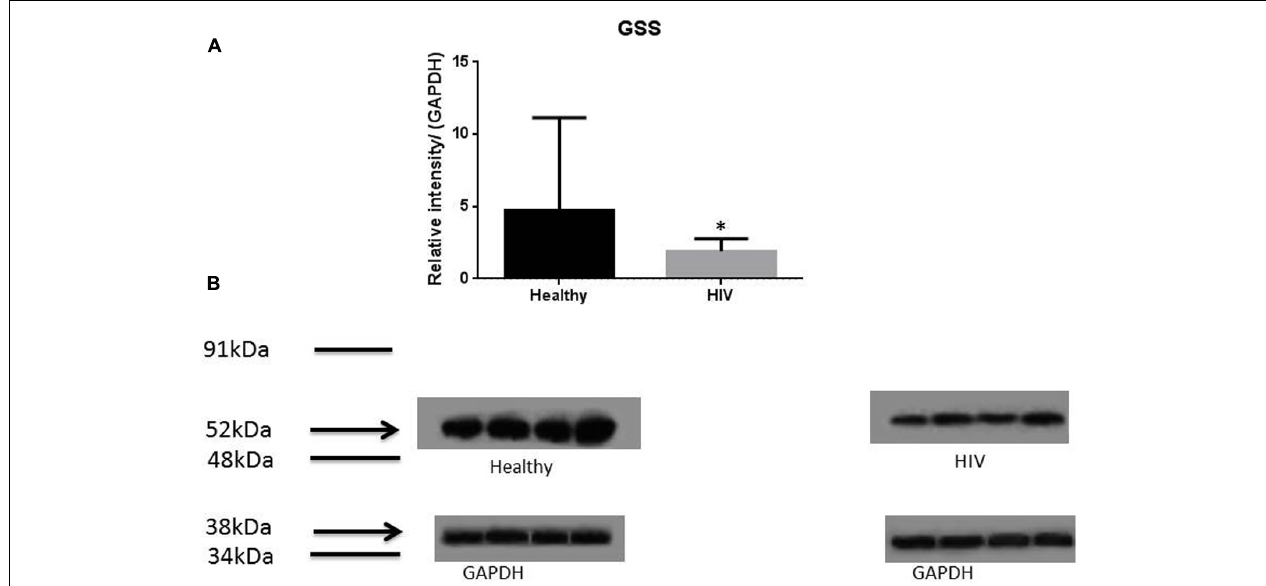
compared to healthy individuals. Data in (A) represents significant difference in the levels of GSS between RBCs isolated from eight healthy individuals and eight individuals with HIV infection (* p ≤ 0.05). (B) : Illustrates representative images of GSS and their corresponding GAPDH bands from four healthy subjects and four individuals with HIV infection.